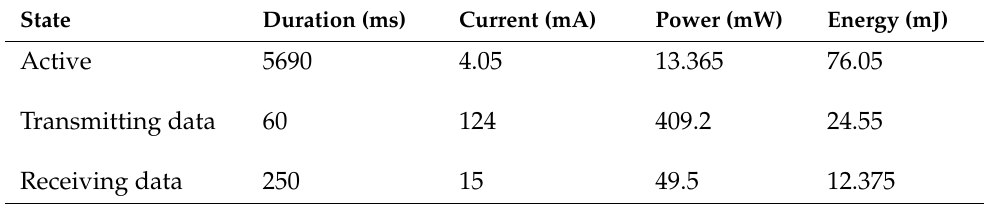
Table 1. Energy profile of weather station for one cycle of active and sleep modes.